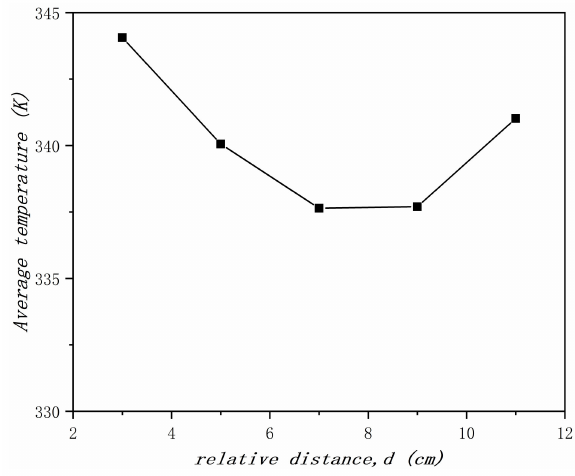
Figure 3. Comparison of average temperature of heat